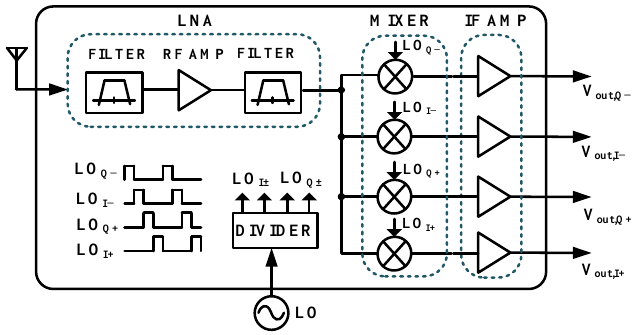
Figure 2. Block diagram of the ULP receiver with NPSC networks.